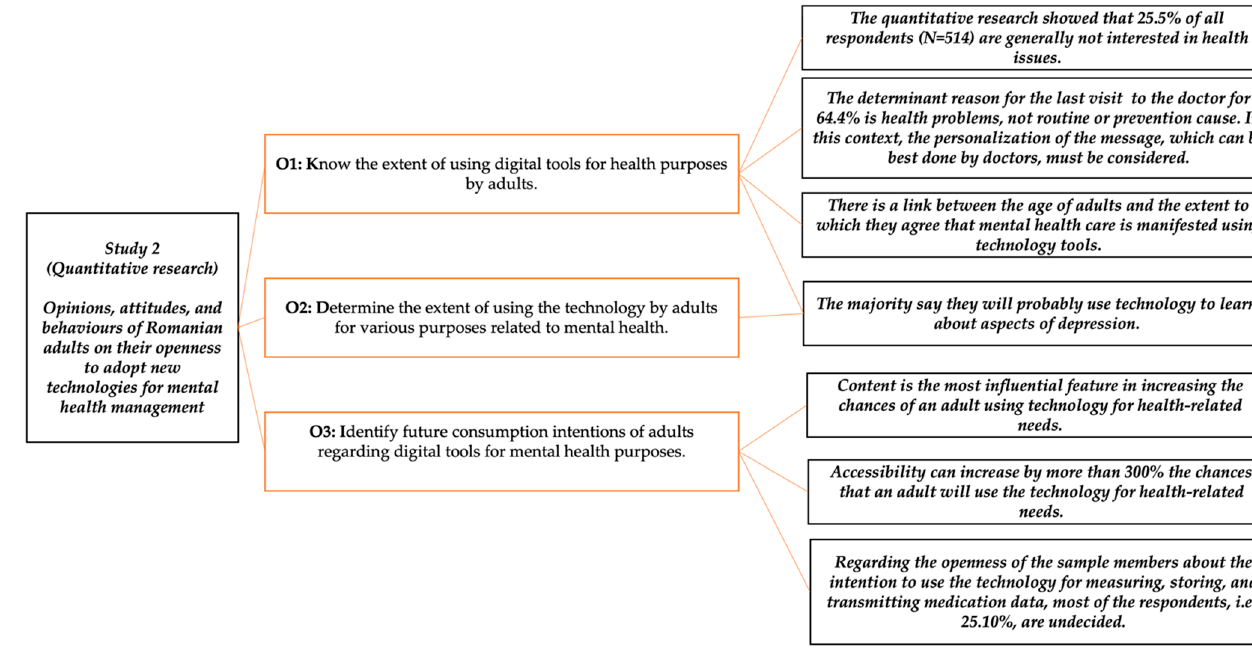
Figure 18. The second study (quantitative research overview).